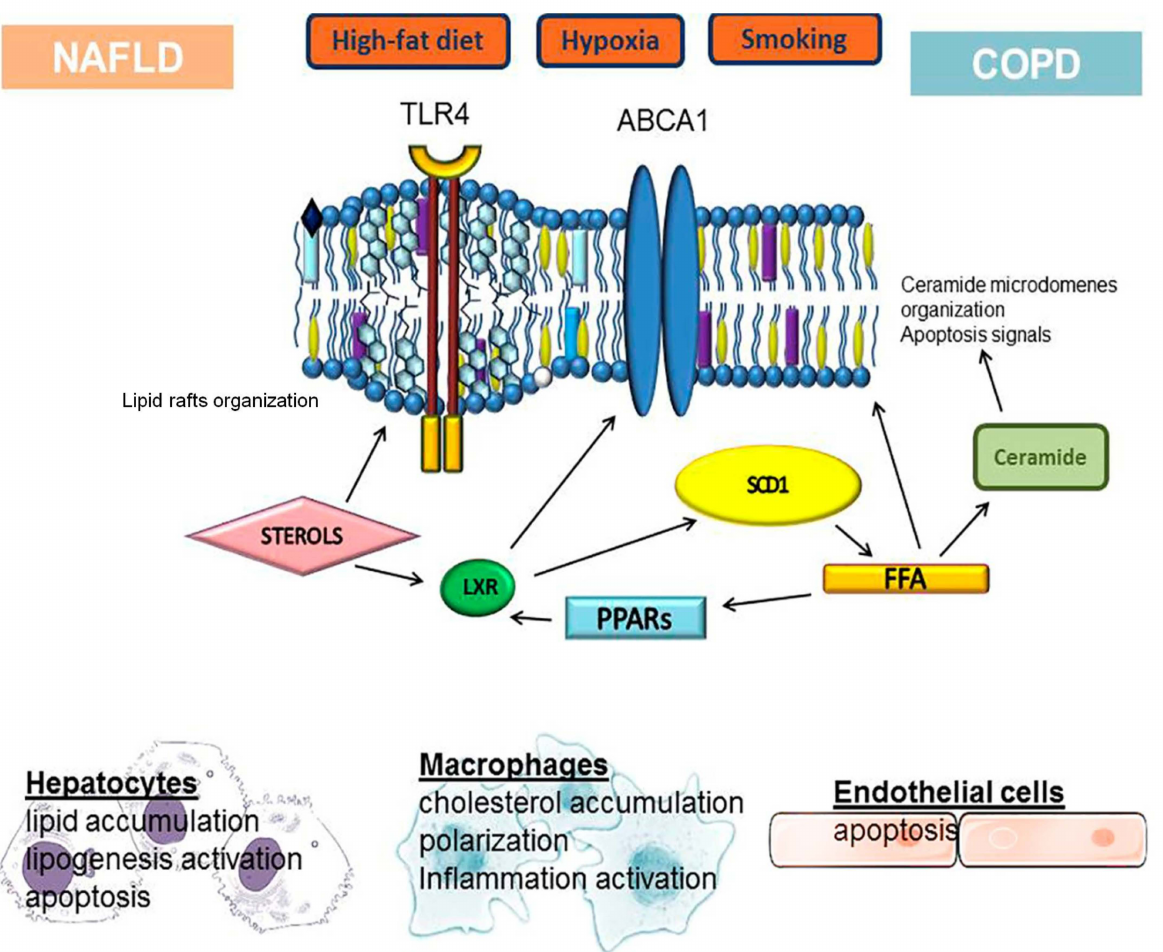
Figure 3. Schematic demonstrating the key initiating, intermediate, and resulting factors associated with cellular disorders of lipid metabolism in the pathogenesis of NAFLD and